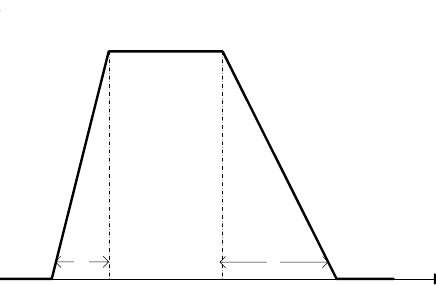
Figure 6. Shape of the trapezium function of a fuzzy set. For the plausibility check the grade of the membership of the measured value in the current fuzzy plausibility interval is a measure for the reliability of the